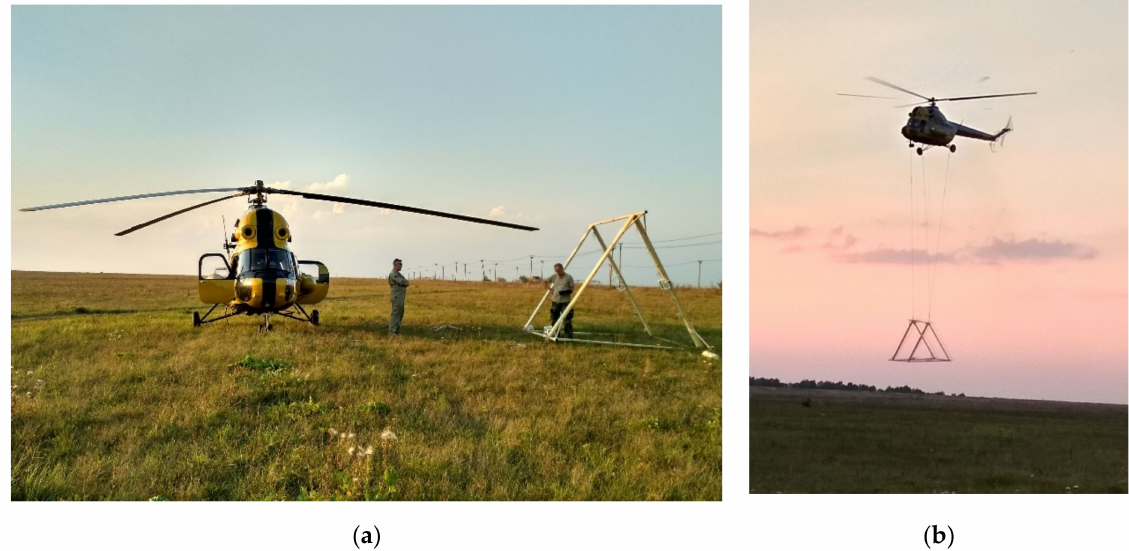
Figure 1. Airborne GPR on the landing field ( a ) and in flight ( b